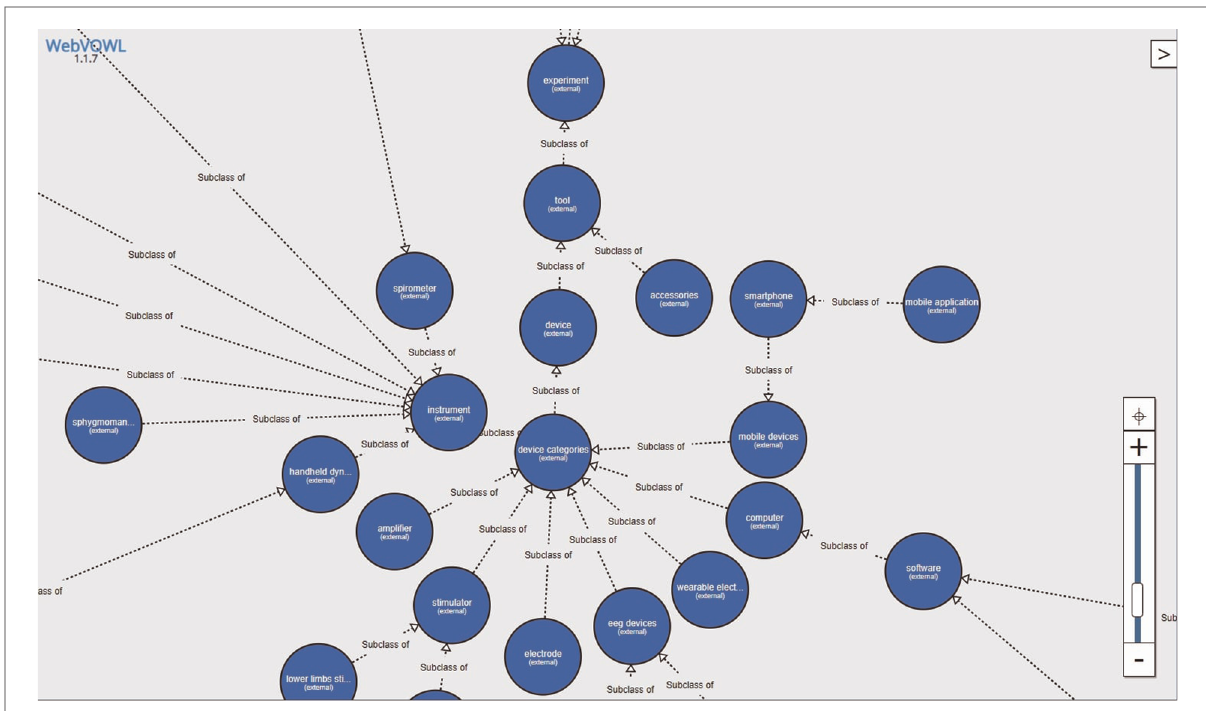
FIGURE 8 Body in Numbers ontology — the parent node “ Device categories ” contains links to its child and sibling nodes. Only the subclasses are visualized (without any additional de fi ned properties). The ontology was visualized with WebVOWL: Web-based Visualization of Ontologies, version 1.1.7, available at